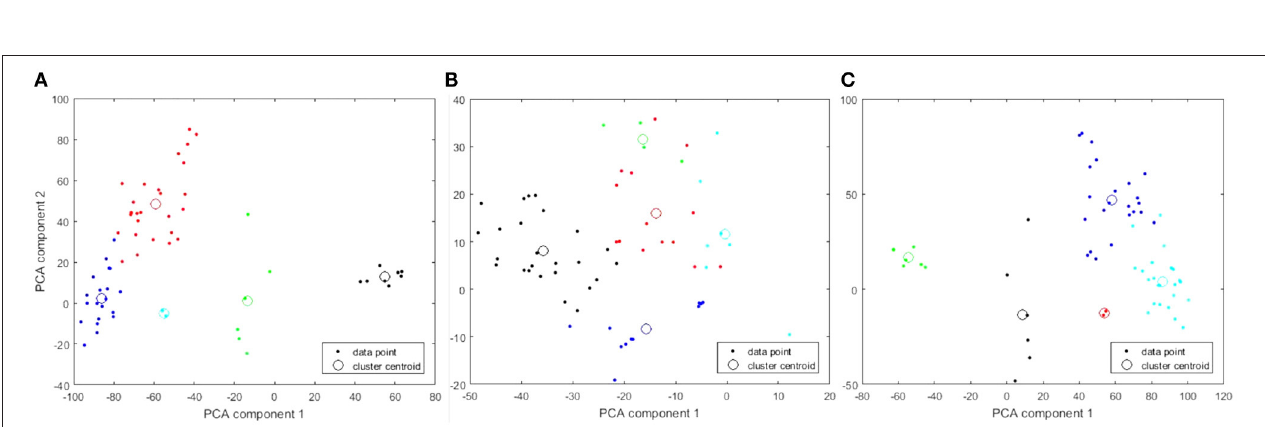
FIGURE 1 | WCSS error plotted against the number of cell clusters. (A) 19 K gene expression features showing an elbow-point at approximately five clusters. (B) 20 K copy number variation features did not show a clear point of inflection. (C) The combined features of gene expression and copy number variation was similar to gene expression